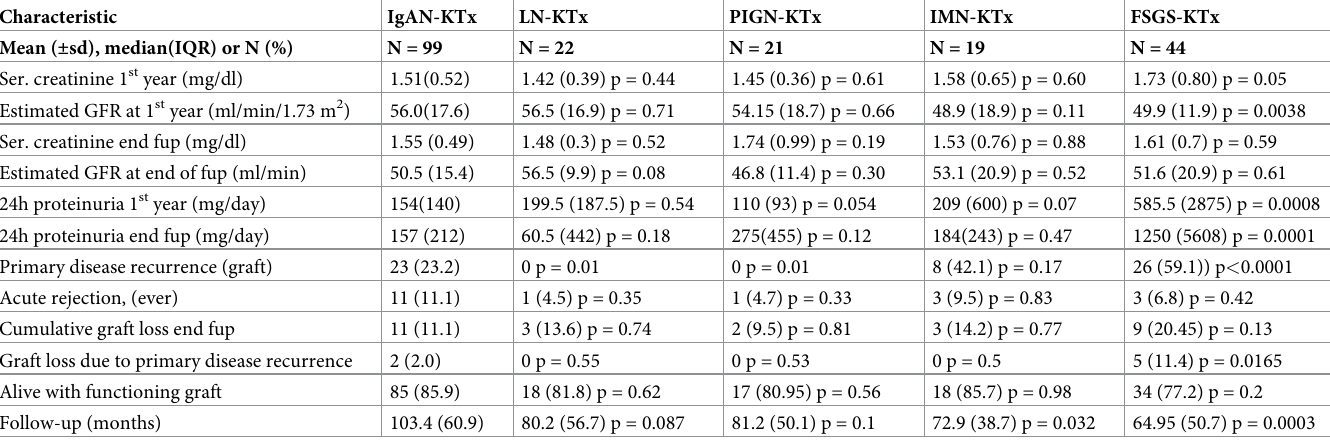
Table 3. Comparison of outcomes between KTx recipients with IgAN as primary cause of ESKD and those with other types of glomerular diseases. Characteristic